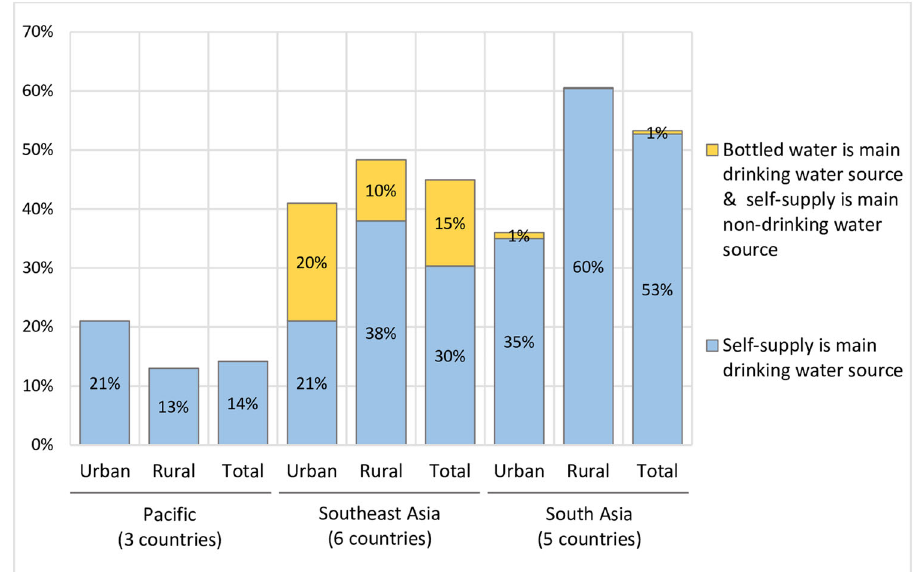
Fig. 2 Proportion of population relying on self-supply when including non-drinking use in conjunction with bottled water. Analysis is based on data from 14 countries with surveys that ask about non-drinking water sources for households that use bottled water as a main drinking water source. This includes three countries in the Paci fi c (Kiribati, Papua New Guinea and Vanuatu), six countries in Southeast Asia (Indonesia, Lao PDR, Philippines, Thailand, Timor-Leste and Vietnam) and fi ve countries in South Asia (Bangladesh, Bhutan, Maldives, Nepal and Pakistan).